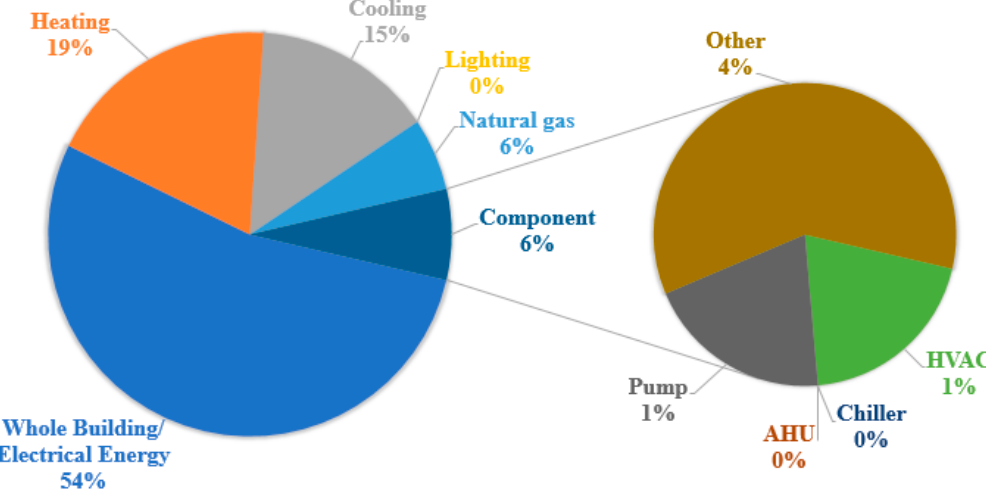
Figure 6 . Compositional breakdown for target variables deep learning (DL)-based models . Figure 6. Compositional breakdown for target variables deep learning (DL)-based